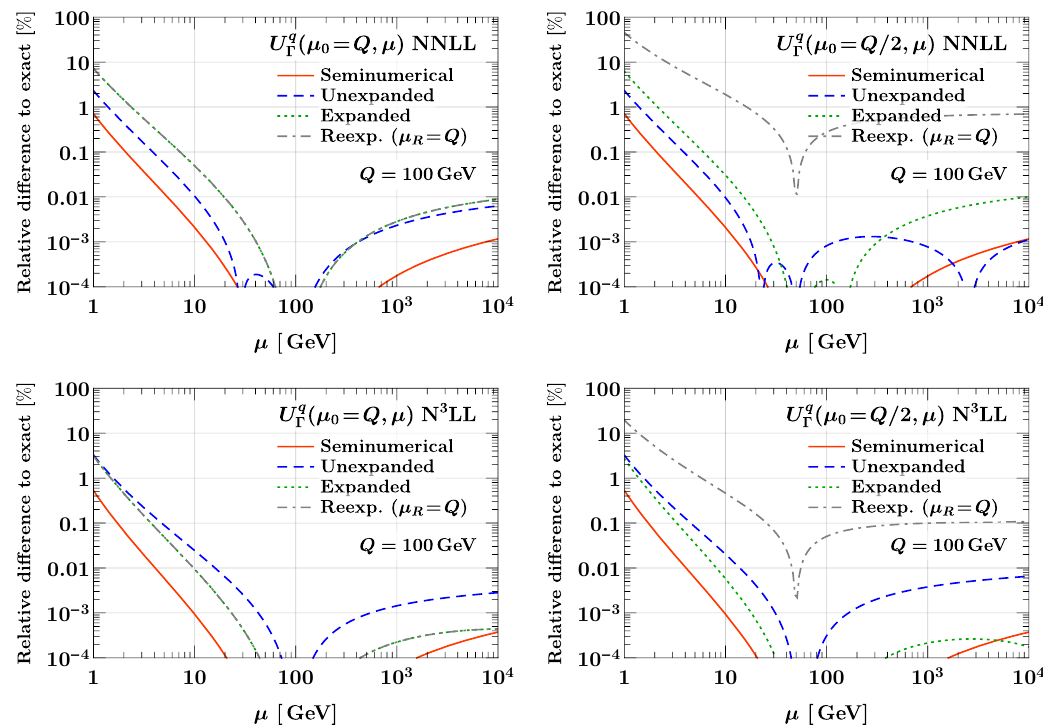
Figure 7 . Deviation from the exact result for the quark cusp evolution kernel at NNLL (top) and N 3 LL (bottom) for all four approximate integration methods. On the left we use (cid:22) 0 = Q , for which the expanded and reexpanded kernels are equivalent. On the right we use (cid:22) 0 = Q= 2, with (cid:22) R = Q for the reexpanded